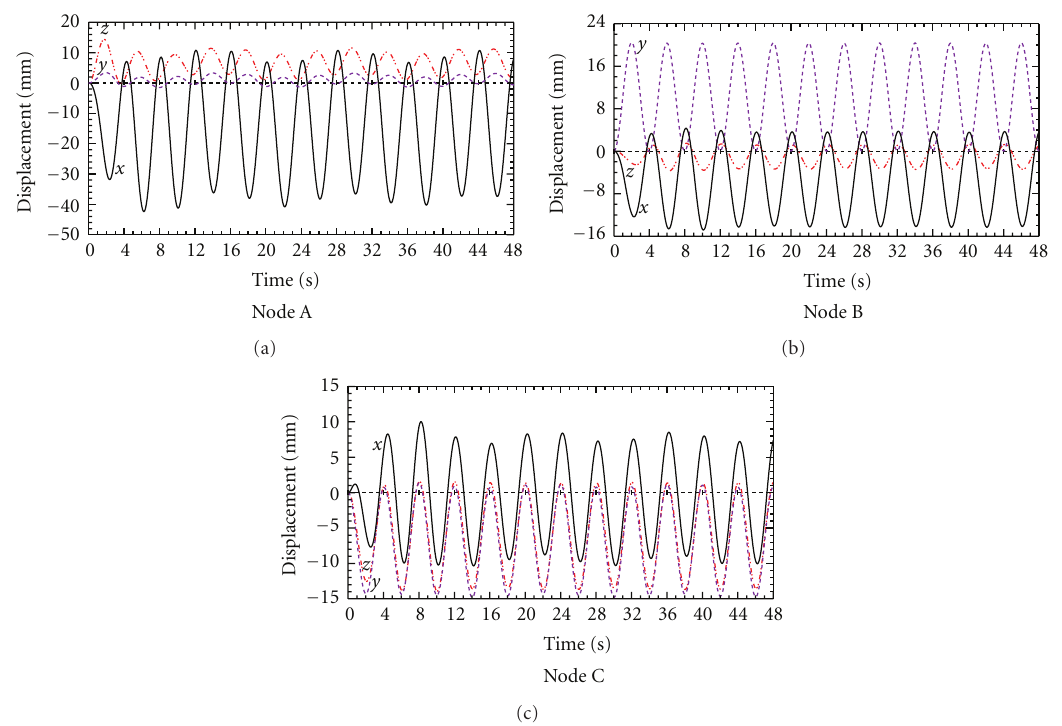
Figure 12: Predicted displacement for nodes A, B, and C over 12 breathing cycles with anisotropic YM model.